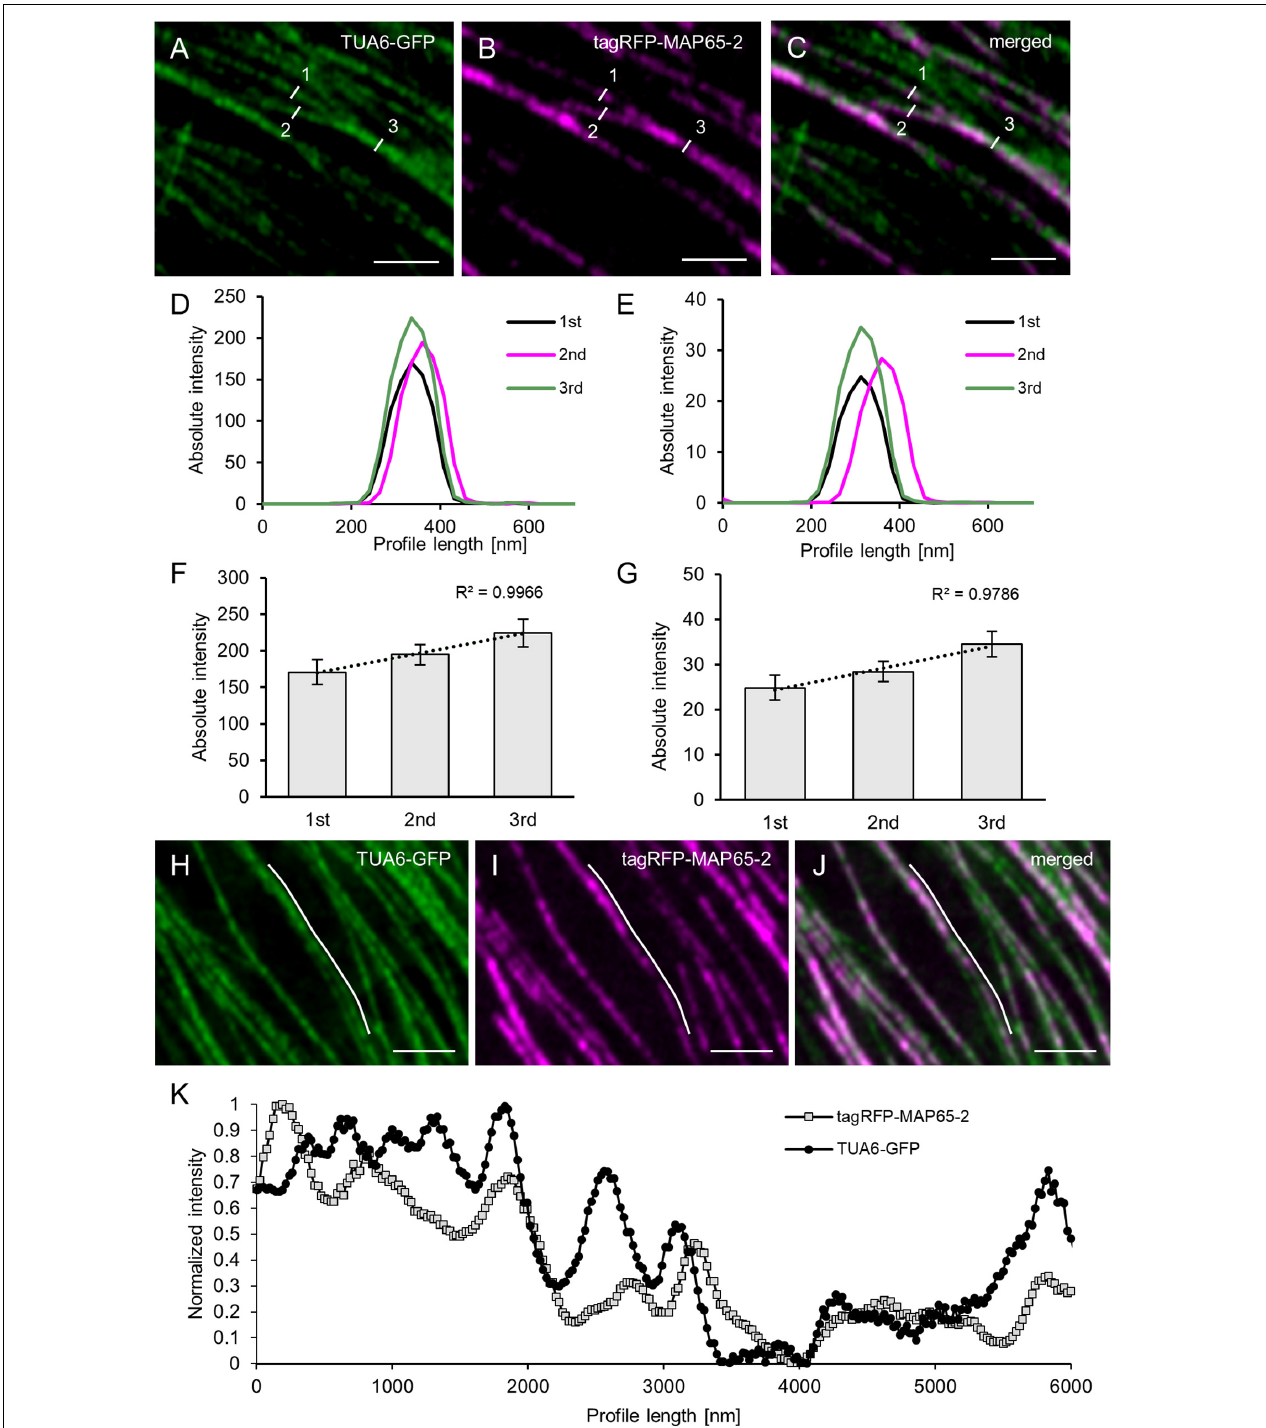
FIGURE 5 | Quantitative analysis of MAP65-2 colocalization with cortical microtubules. Hypocotyl epidermal cells of stably transformed Arabidopsis lines expressing both tagRFP-MAP65-2 and TUA6-GFP were observed in ACLSM (objective 63 × /1.40 NA). (A–C) Overview of an area with microtubule branching with TUA6-GFP shown in green (A) , tagRFP-MAP65-2 in red (B) and (C) the showing the overlay; measured microtubule bundles are visualized with white lines and labeled with given numbers according to their strength (1 being the weakest and 3 the strongest bundle). Microtubule bundles were quantified by fluorescence intensity profiling and averaged values are shown in (D) for TUA6-GFP and (E) for tagRFP-MAP65-2. Quantitative evaluation is given in (F) for TUA6-GFP and (G) for tagRFP-MAP65-2 (mean ± SD; R2, linear correlation coefficient; N = 8, 5 technical repetitions). (H–J) Overview of a microtubule bundle, TUA6-GFP shown in green (H) , tagRFP-MAP65-2 in red (I) and (J) is a merged picture; white line visualizes longitudinal profile, which is shown in (K) , where is demonstrated fluctuation of fluorescence intensities. Scale bars = 2 µ